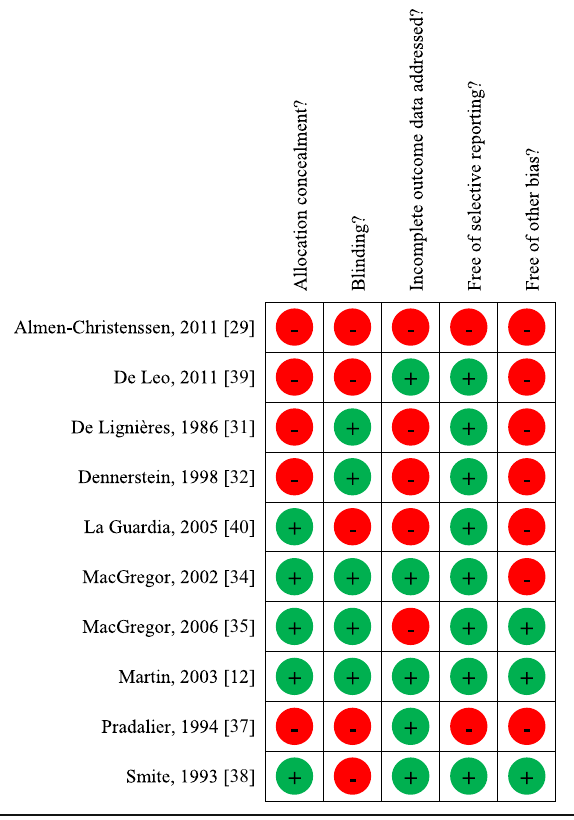
Table 6 Rating of the quality of evidence for individual interventional